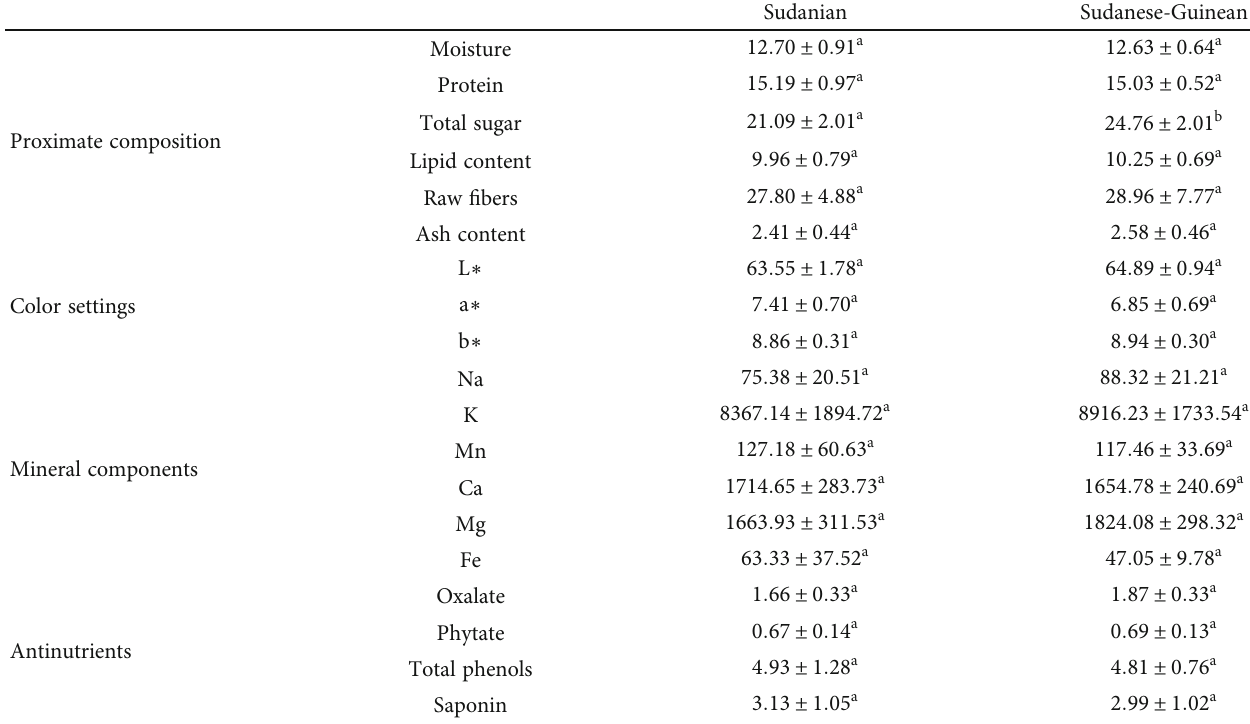
Table 5: In fl uence of phytogeographical zones on the physicochemical characteristics of Detarium microcarpum seeds. Sudanian Sudanese-Guinean